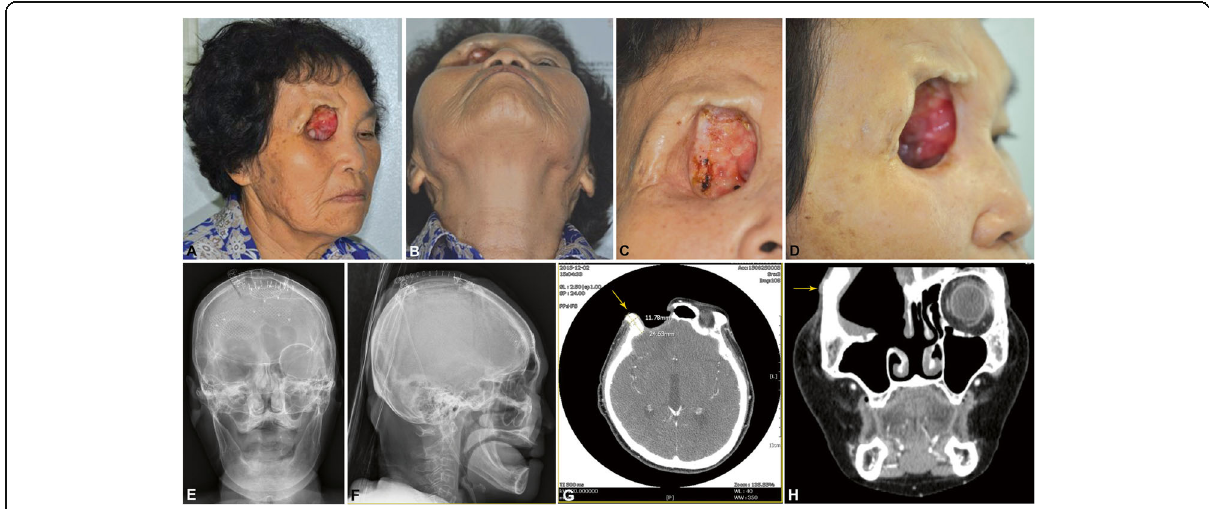
Fig. 1 The patient ’ s clinical and radiographic views after orbital exenteration. The orbital defect on the right side of the face ( a – d ), frontal ( e ), and lateral ( f ) skull views, and computed tomography axial ( g ) and coronal ( h ) views are shown along with measurements of residual bony